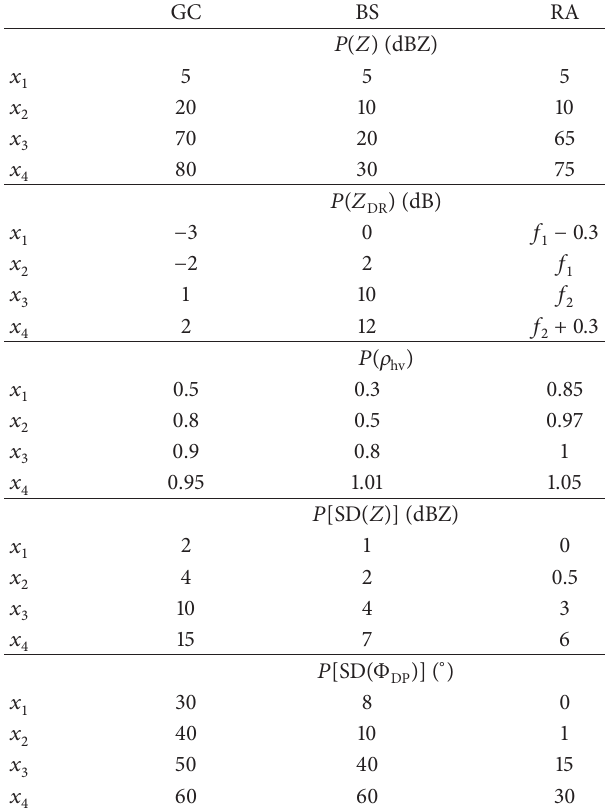
Table 1: Parameter values of the membership functions used by the simplified HCA for the three classes. Reflectivity-dependent parameters 𝑓 1 and 𝑓 2 are defined in (3) and (4), respectively.